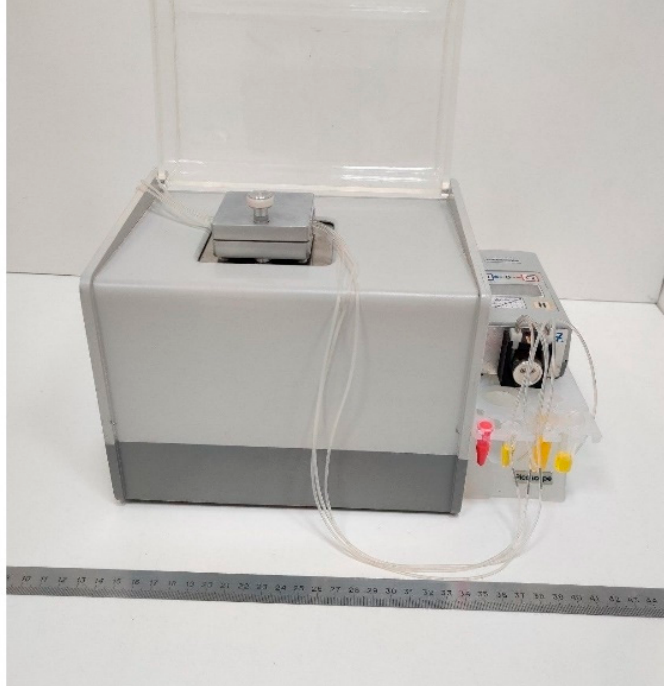
Figure 1. Photograph of the multiplex label-biosensor based on the spectral-correlation interferometry.